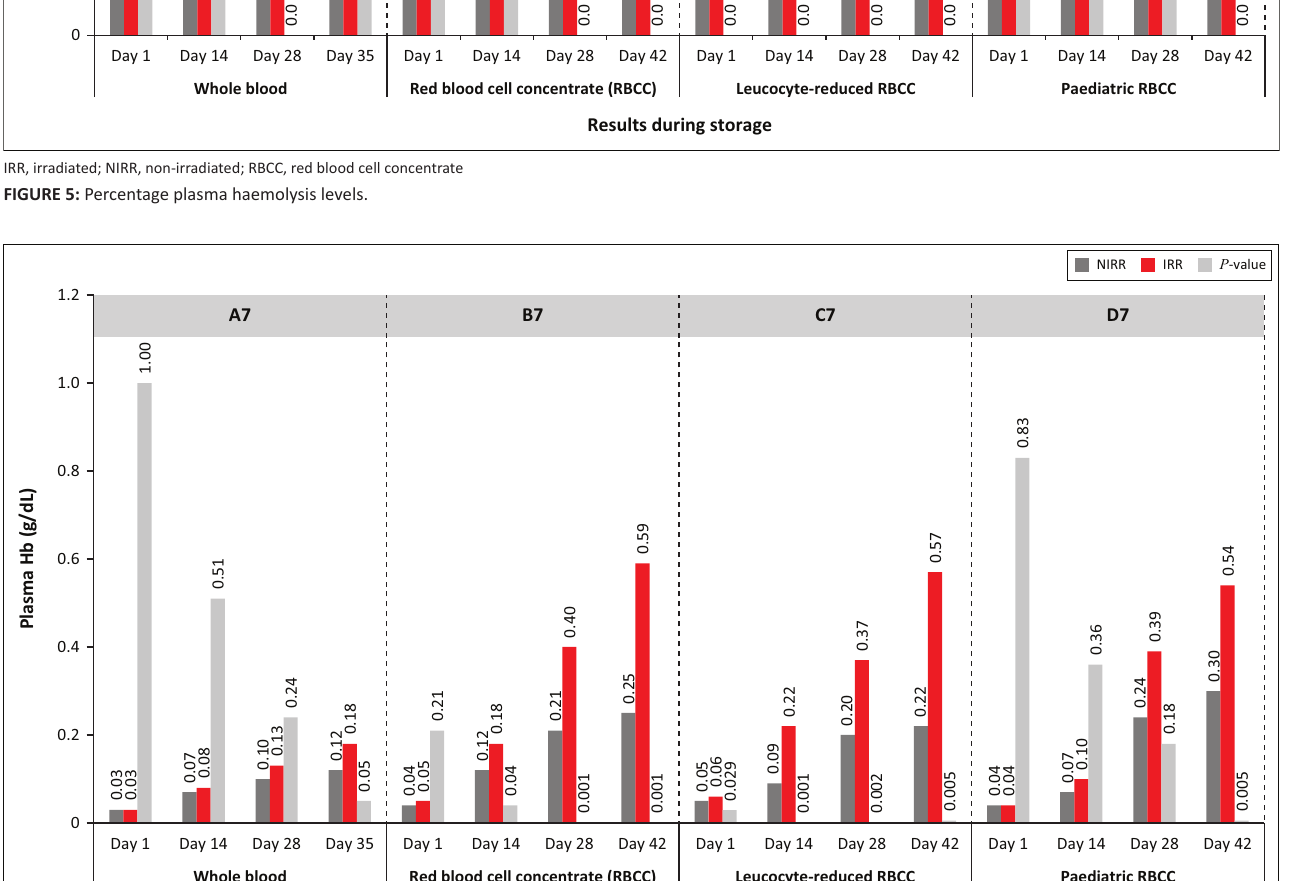
FIGURE 6: Plasma haemoglobin